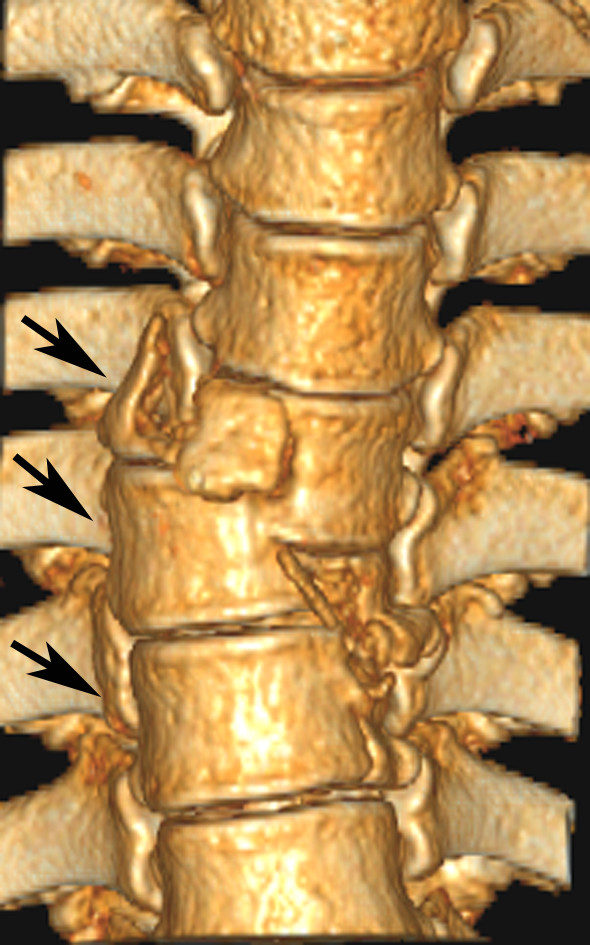
Surface-shaded display of a 51-year-old female patient shows type C3 lesions from T5 through T7.